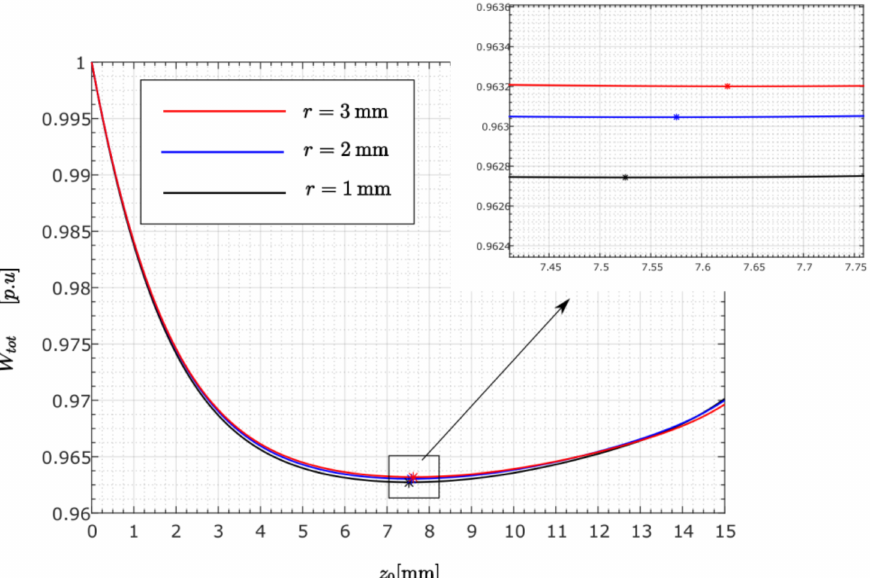
Figure 15. The PM’s equilibrium height calculated by EM. The results are shown for three different values of the rod’s radius, i.e., r = 1 mm, r = 2 mm and r = 3 mm, respectively. The minimum value on the individual curve is indicated with the Asterisk (*). Each of the curves was nor-malized by its maximum value.